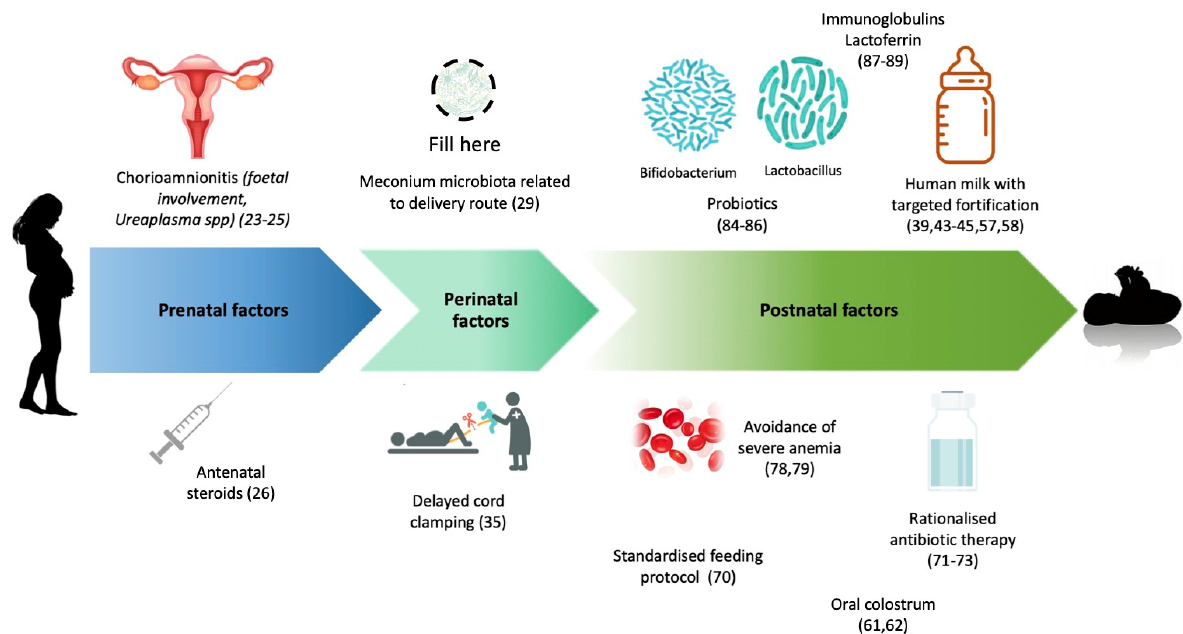
Figure 1. Prenatal, perinatal and postnatal factors which have been found, with stronger or weaker recommendation, to reduce the subsequent risk of NEC development. The role of certain factors, like chorioamnionitis, meconium at birth, delayed cord clamping, oral colostrum, is still debated. Icons from Freepik and Pch.vector, downloaded from